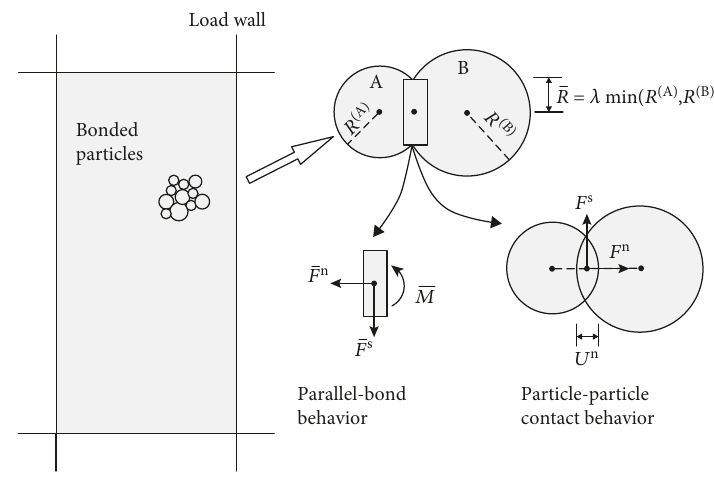
Figure 1: Sketch map of the bond particle